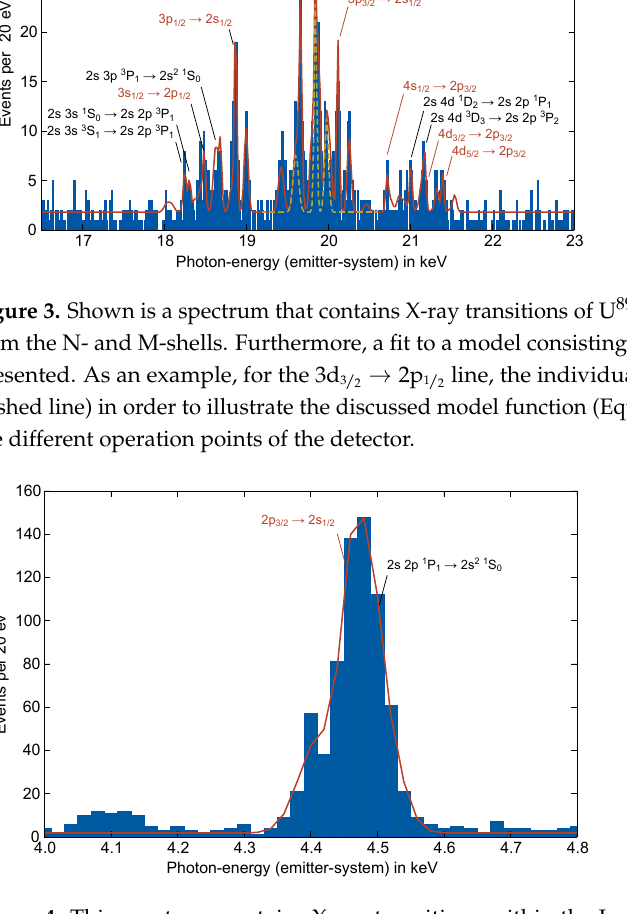
Figure 4. This spectrum contains X-ray transitions within the L-shell of U 89 + (red text) as well as U 88 + (black text). Additionally, a fit to a model containing all identified lines is plotted (red line).